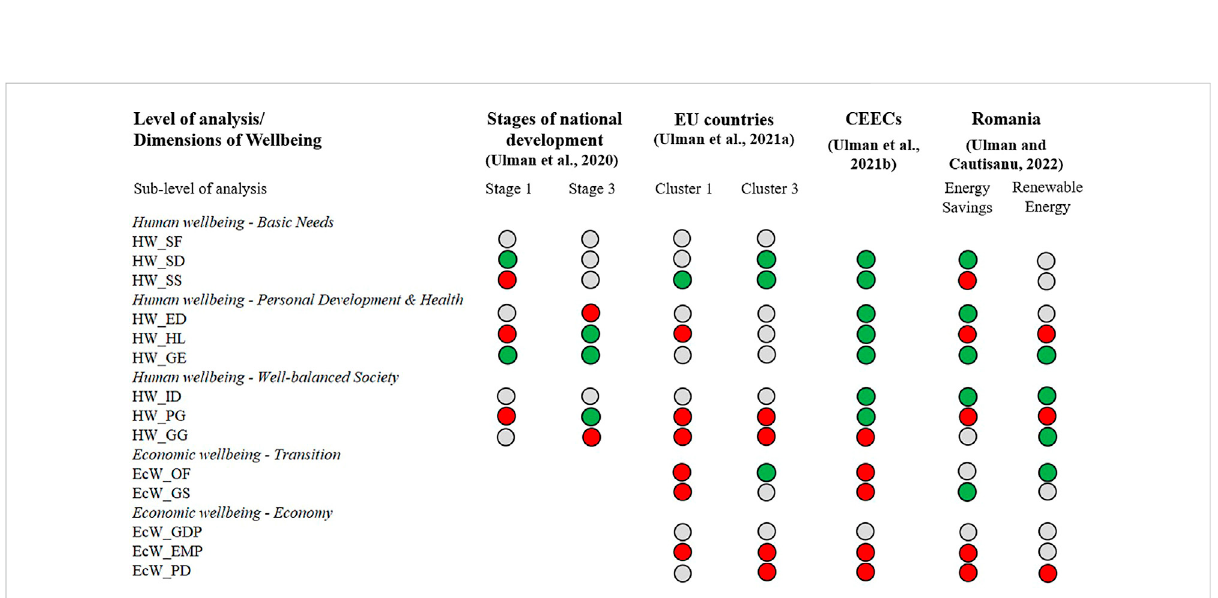
FIGURE 3 Synthesis of main results obtained from previous studies using the SSI